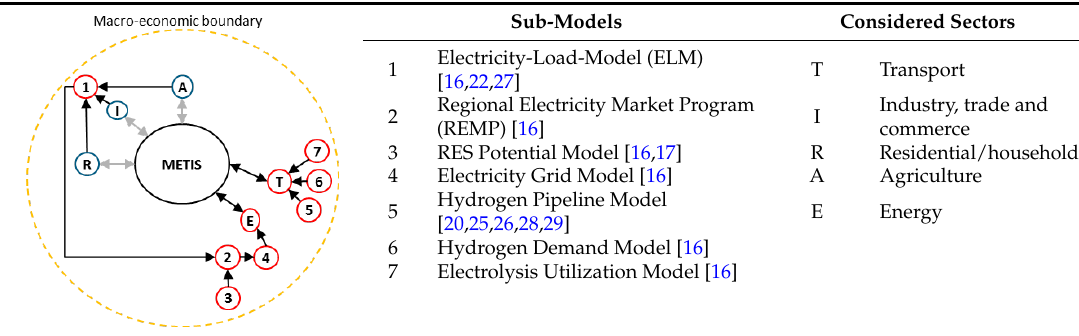
Table 1. The utilized sub-models of models for energy transformation and integration systems (METIS) for this paper.